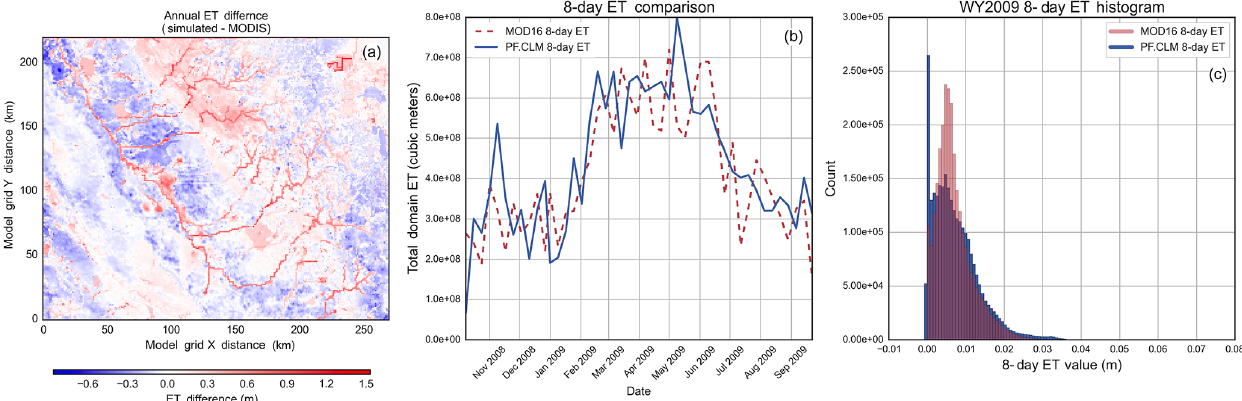
Figure 5. Comparison of simulated evapotranspiration (ET) to MODIS estimates over the SJBM domain. (a) Annual difference in ET (m) is shown spatially. Note the high simulated ET in channels and riparian zones, which are not captured in the MODIS product. (b) Time series of spatially averaged 8-day ET values for SJBM and MODIS show good agreement. (c) Histogram of 8-day ET values shows higher variance in SJBM